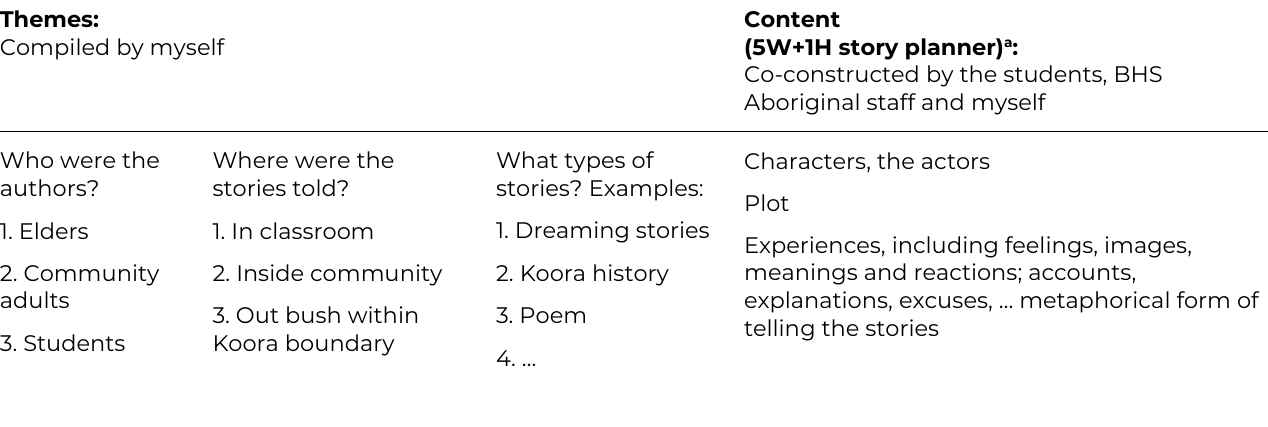
Table 2: Stories: Themes and Content Combination